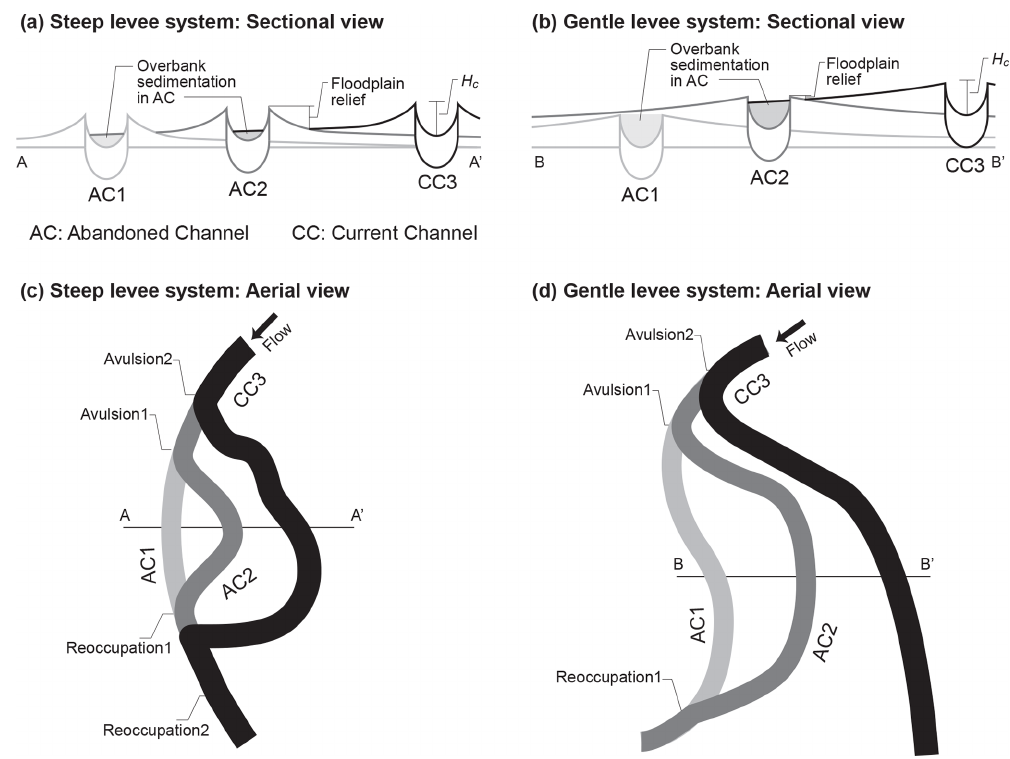
Figure 8. Schematic of abandoned channel infillings under (a) steep levee system and (b) gentler levee system, and (c) annexational avulsion style with steeper levees, and (d) progradational avulsion with gentle levees both of which are modified from Slingerland and Smith